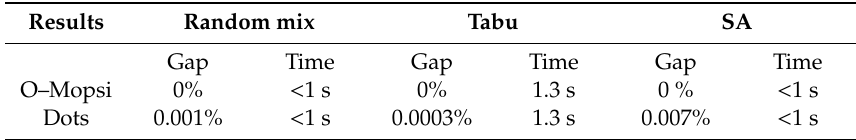
Table 5. Summary of overall results